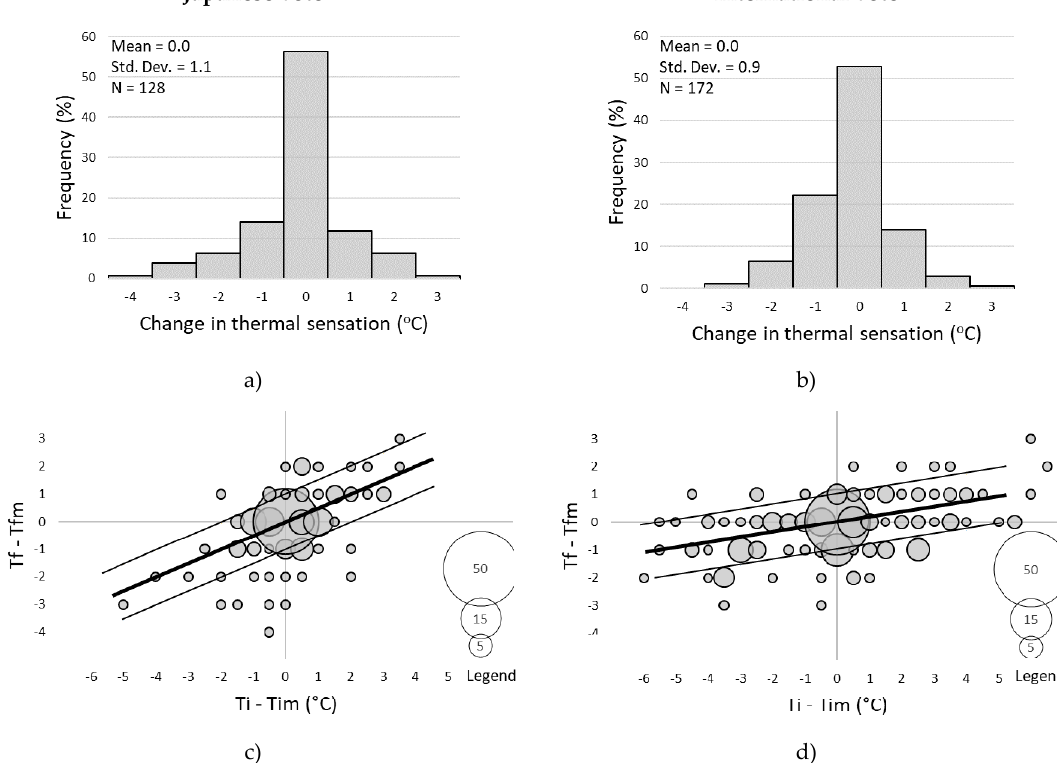
Figure 14. Room-wise day-survey averages ( a ) frequency distribution of the Japanese vote; ( b ) frequency distribution of international vote; ( c ) regression of the day surveys from the Japanese vote; ( d ) regression of the day surveys from the international vote. Note: Outer lines indicate the residual standard deviation